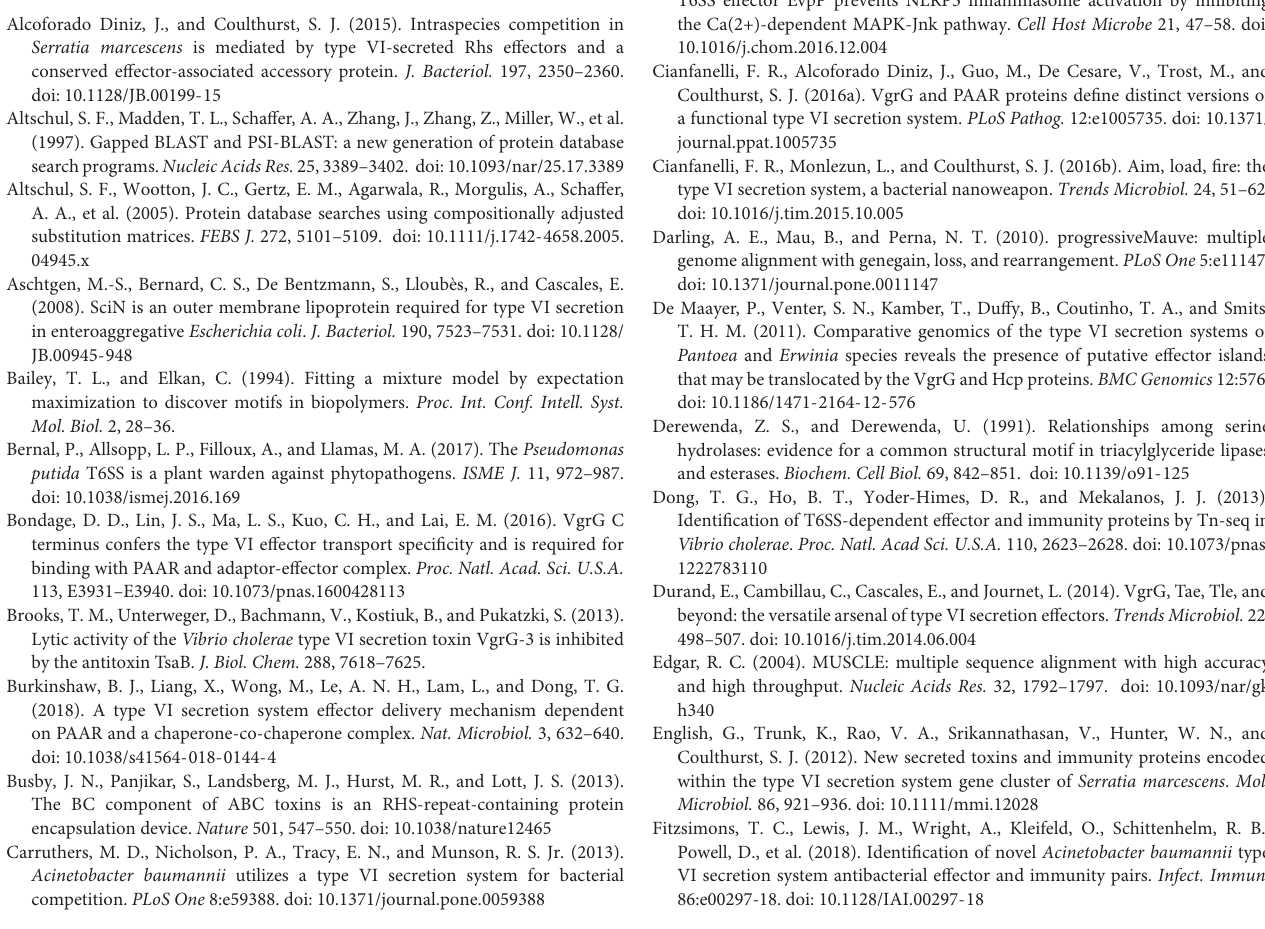
then the number of the group the effector region belongs to (based on effector groups, see ML phylogenetic tree shown in Figure 2 ). (a) Nexus file of